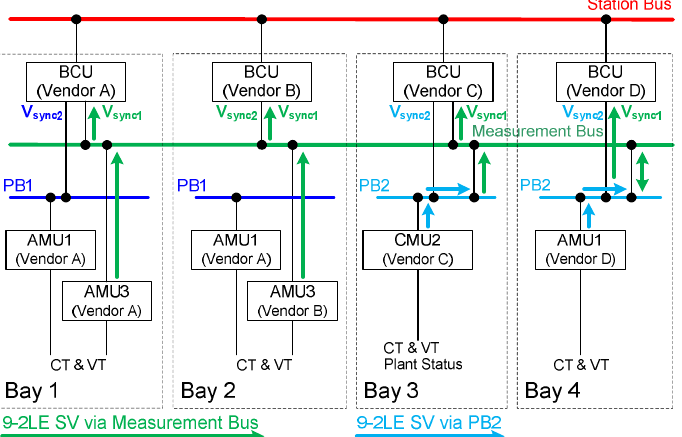
Figure 9. Inter-bay SVs via the measurement bus for synchronisation.